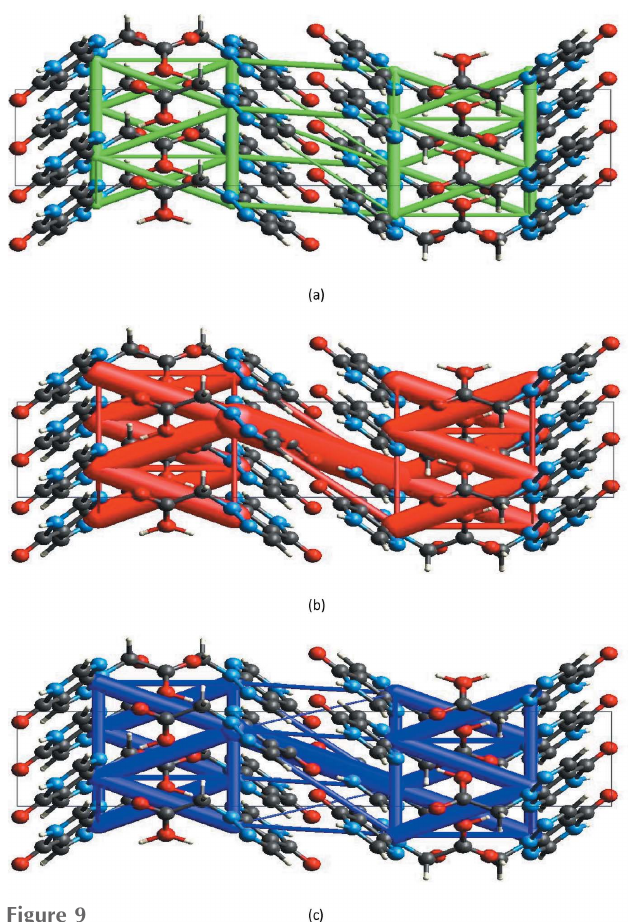
Figure 9 The energy framework for a cluster of molecules of (I) viewed down the a- axis direction (the b axis is vertical and the c axis is horizontal) showing ( a ) electrostatic energy, ( b ) dispersion energy and ( c ) total energy diagrams. The cylindrical radius is proportional to the relative strength of the corresponding energies and they were adjusted to the same scale factor of 80 with cut-off value of 5 kJ mol (cid:4) 1 within 1 (cid:6) 1 (cid:6) 1 unit cells.